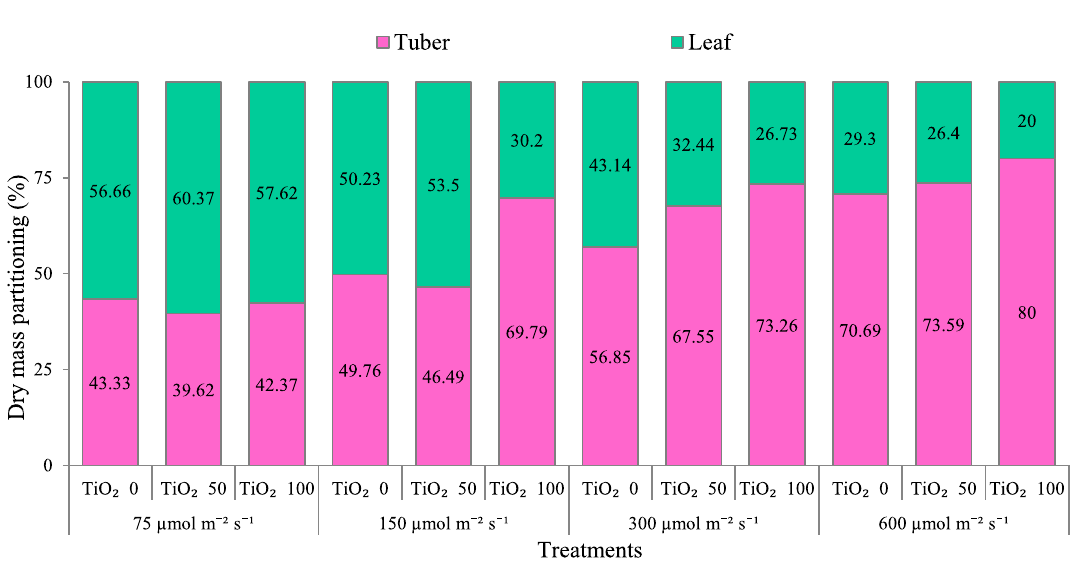
Figure 3. Effect of cultivation light intensity (75, 150, 300 and 600 µmol m −2 s −1 ) and spray treatment (once a week, and three times in total) with titanium dioxide (TiO 2 ) nanoparticles (0, 50 and 100 µmol L −1 ) on biomass partitioning of radish cv. Cherry belle plants. Six replicate plants were assessed per